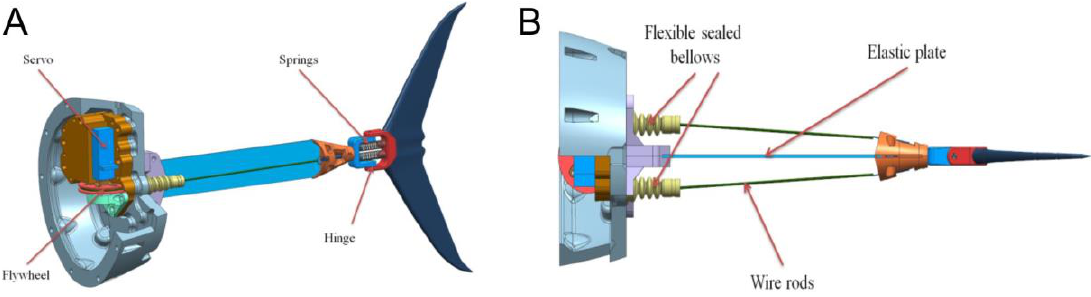
Figure 2. Robotic fish propulsion system. ( A ) The tail fin is connected to a servomotor; ( B ) muscular ligaments-like wire provides flexor/extensor movement of the tail fin mounted to the elastic rod. Tail oscillations were provided by two wire rods playing the roles of flexors and ex- tensors mimicking muscular contractions. The resulting robotic fish demonstrated quali- tatively thunniform movement when the tail oscillations were converted into translational motion of the whole robot. In our model, the control system can gradually change the amplitude and frequency of tail oscillations. In computer simulations, we also tested the robot’s movement in an aquatic environ- ment using ANSYS software. The main goal of optimizing the movement of a robotic fish was to achieve the best possible relationship between tail geometry and the power con- sumption of the drive, which was the basic driving force. A prototype was developed to verify the computer model of a biomorphic mover, which can simulate the movement of fish. Calculations included several stages: building a computer model from different com- putational modules presented inside the program, loading the studied geometry (3D model), building a computational grid on the surface of the geometry under study, setting the initial conditions, carrying out calculations, and analyzing the results obtained. Spe- cifically, we looked at the hydrodynamics of the body resistance arising in the fluid flow using our 3D model. The results are shown in Figure 3. Figure 3. Simulation of body resistance profile of the 3D fish robot movement in an aquatic medium with constant flow. Color grade corresponds to values of the flow speed. 3. Fish Swimming Experiments For physical experiments with the robotic fish, we developed the experimental setup shown in Figure 4. The setup was capable of registering the kinematics of swimming. It